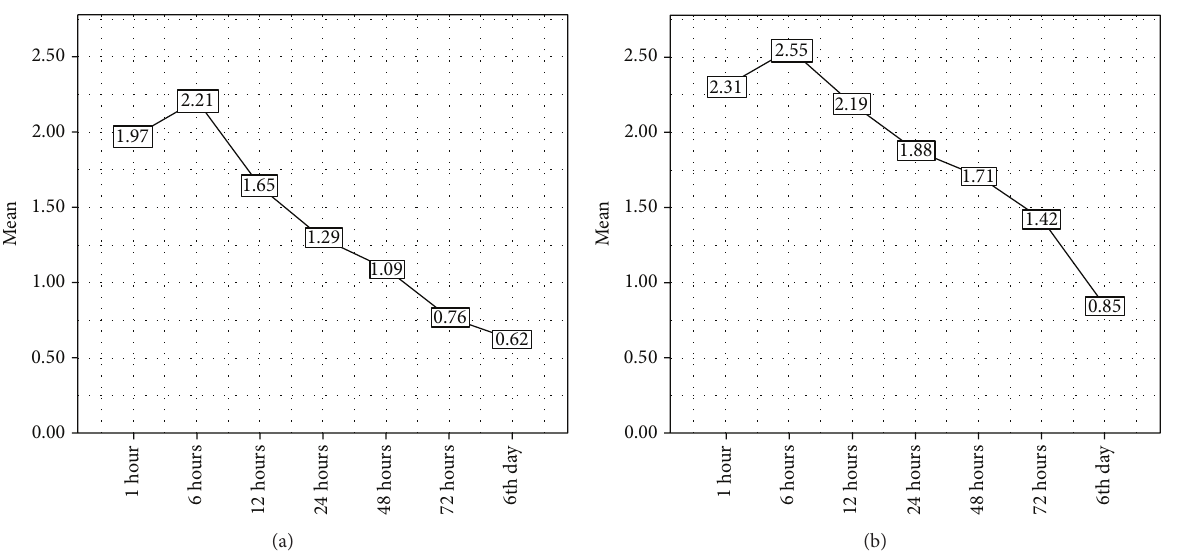
Figure 6: Pain trend over 6 days in the antibiotic (a) and nonantibiotic (b)